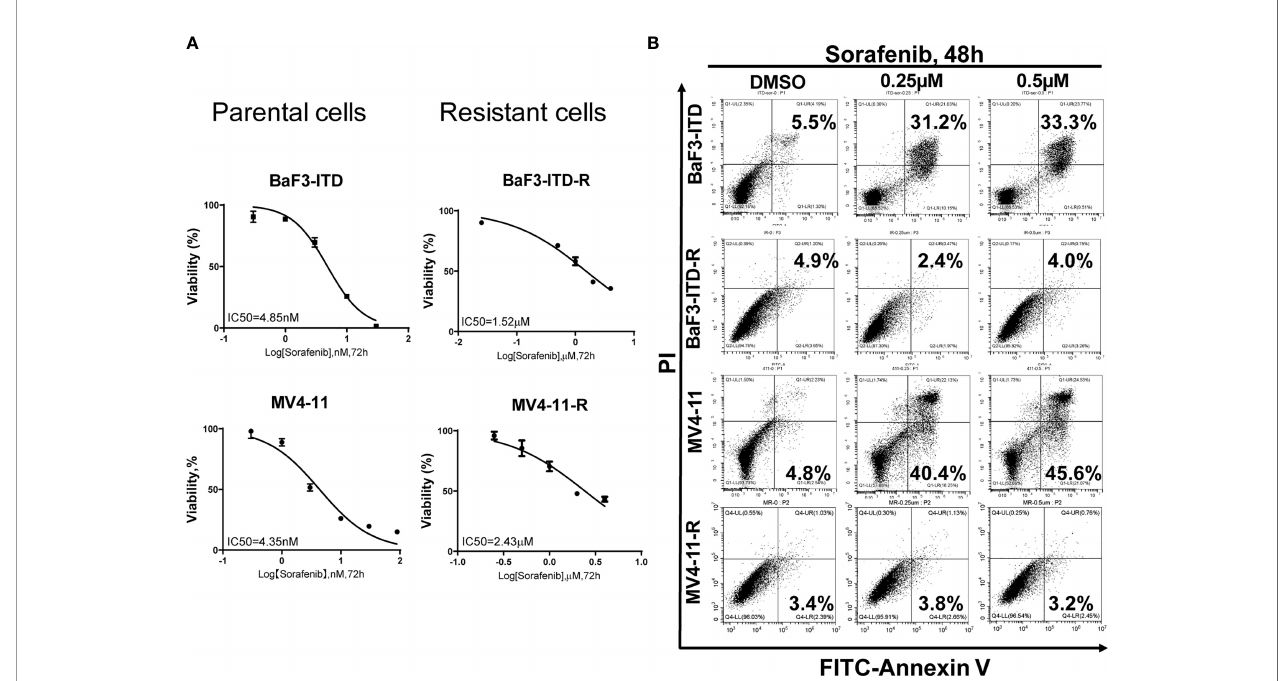
FIGURE 1 | Comparison of the cell proliferation and apoptosis of the parental and sorafenib-resistant cell lines in the presence of sorafenib. (A) The sorafenib-resistant cells, MV4-11-R and BaF3-ITD-R, and parental BaF3-ITD and MV4-11 cells were incubated with increasing concentrations of sorafenib for 72 hours. Cell viability (%) was compared. Data represent three independent experiments. (B) Cells were exposed to sorafenib at the indicated concentrations for 48 hours. The apoptotic cells were stained with Annexin-V and propidium iodide (PI) for 15 mins and detected by fl ow cytometry in one hour. Data represent three independent